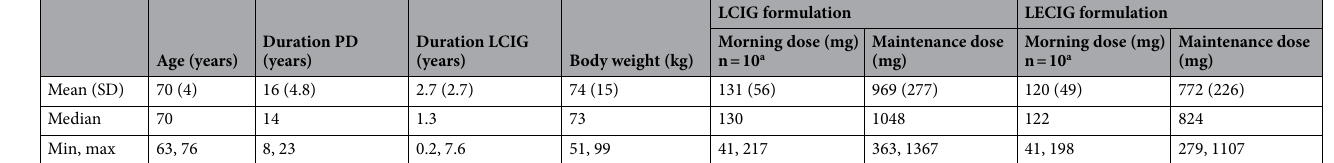
Table 1. Patient characteristics, n = 11 (male n = 7, female n = 4). a One patient did not have a morning dose prescribed. SD, standard deviation; PD, Parkinson’s disease; LCIG, levodopa-carbidopa intestinal gel; LECIG, levodopa-entacapone-carbidopa intestinal